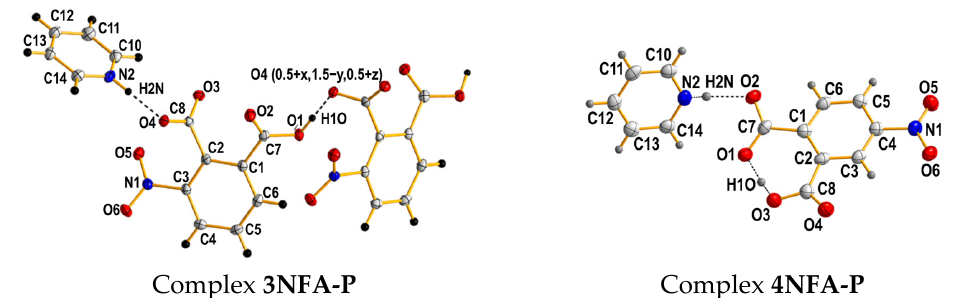
Figure 5. Molecular structures of the 3NFA ‐ P and 4NFA ‐ P complexes. Hydrogen bonds and bonds extending the structure are denoted with dashed lines. Displacement ellipsoids are plotted at 50% probability level.